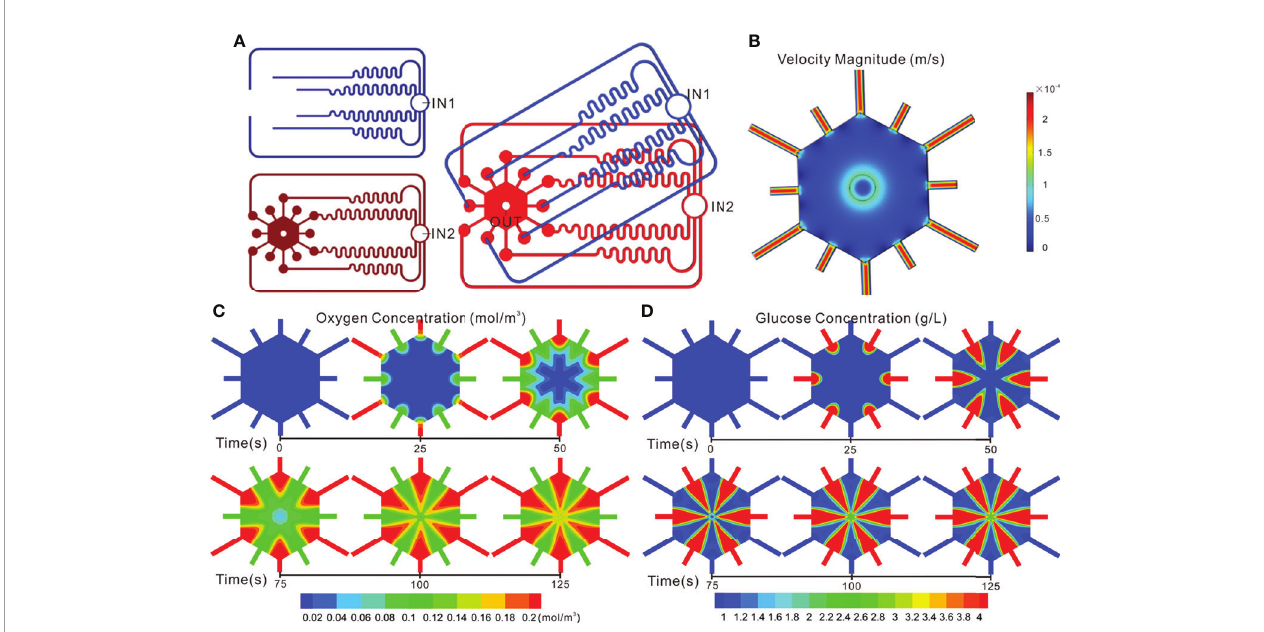
FIGURE 3 | Simulation of fl ow and concentration distribution pro fi les in the TVLOC. (A) The top view of the geometric model; (B) Flow distribution in the TVLOC; (C) The distribution of oxygen concentration in the TVLOC; (D) The distribution of glucose concentration in the